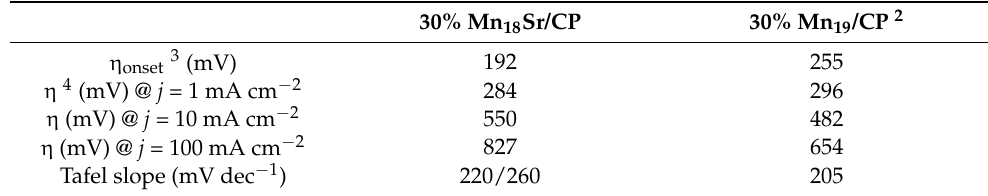
Table 1. Comparison of the electrocatalytic water oxidation performed by 30% Mn 18 Sr /CP 1 and 30% Mn 19 /CP